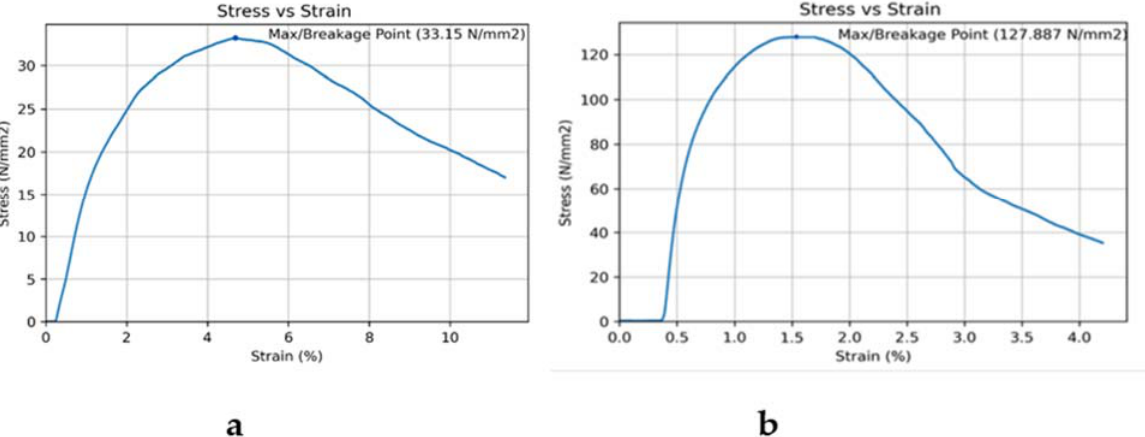
Figure 5. ( a ) Stress–strain curve for two-layered sample (Failed Sample 1) ( b ) Stress–strain curve for four-layered sample (Failed Sample 2).